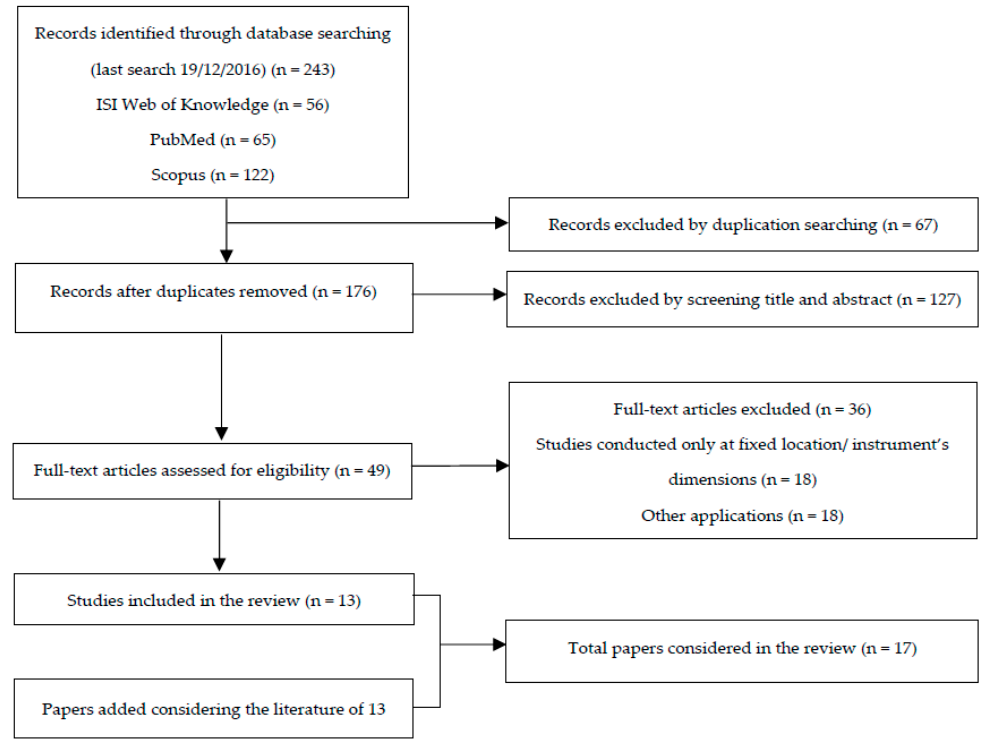
Figure 1. Flowchart of literature searched and reviewed (modified from Moher et al. [35]).